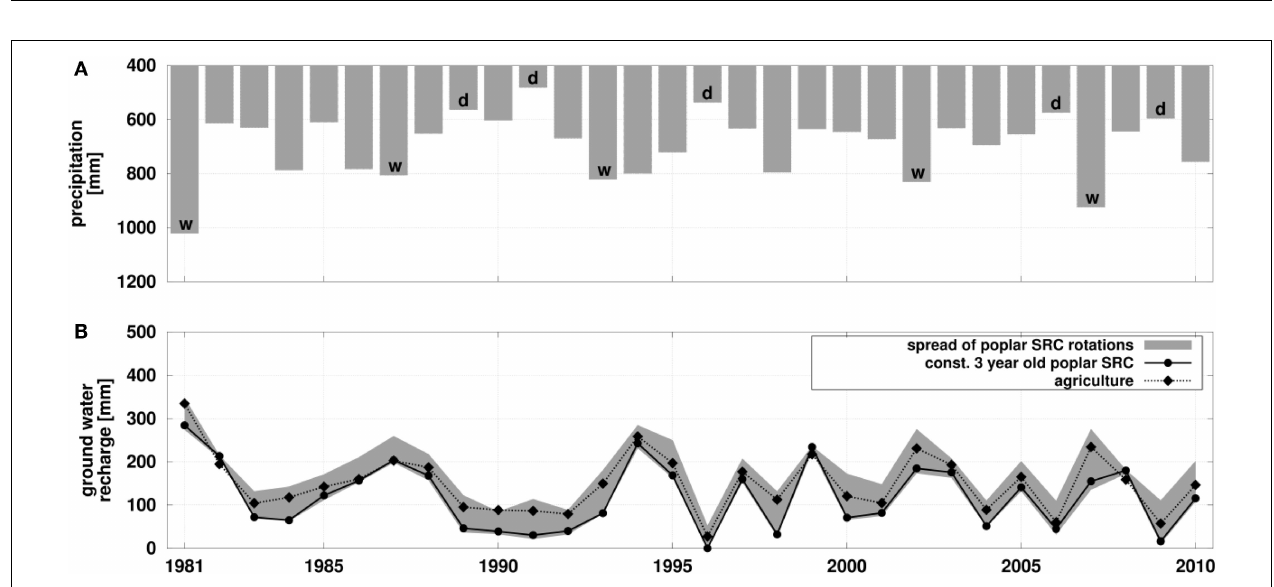
FIGURE 3 | Time series of daily max. temperature, precipitation, leaf area index, stomatal resistance, growth parameters, and soil water changes of a poplar SCR in Reiffenhausen (Lower Saxony) in 2013 . (A) Daily max. temperature and precipitation; (B) measured course of leaf area